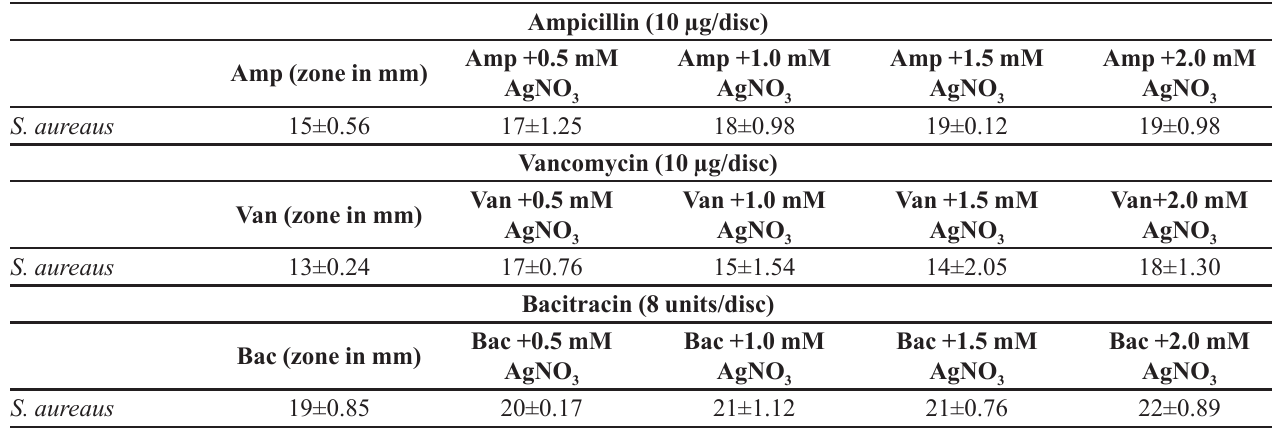
TABLE I - Zone of inhibition for different antibiotics (ampicillin, vancomycin, and bacitracin) against Gram positive bacteria ( Staphylococcus aureus )